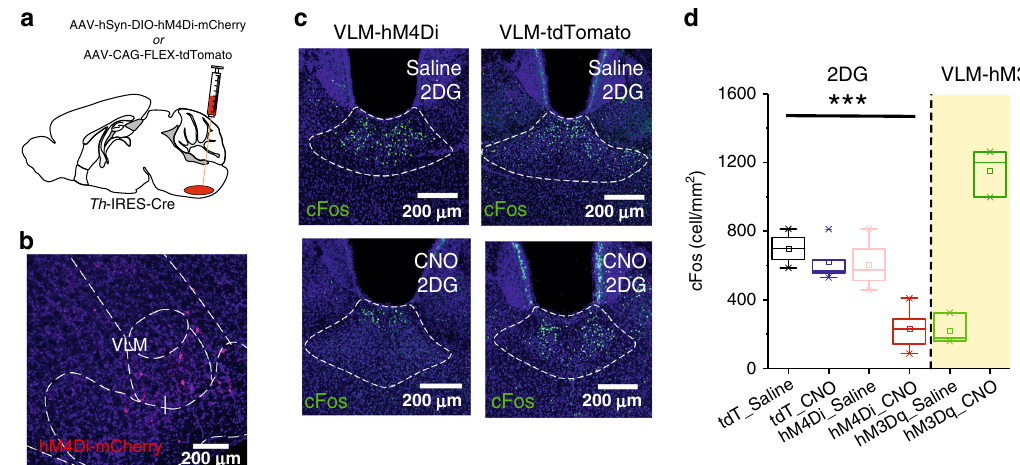
Fig. 6 VLM CA neurons mediate glucoprivation-induced activation of the pPVT. a Schematic of the stereotaxic injections for selective expression of DREADDi (hM4Di-mCherry) in VLM CA neurons of TH-IRES-Cre mice. b Representative images of the VLM from a TH-IRES-Cre mouse expressing the hM4Di-mCherry virus. c Representative images showing cFos immunohistochemistry in the pPVT of mice expressing either the hM4Di-mCherry (left) or tdTomato control virus (right) in the VLM CA and injected with either saline (top) or with CNO (bottom), 30 min before administration of 2DG. d Quanti fi cation of cFos immunoreactivity in PVT as cells/mm 2 , tdT-Saline, 698.85 ± 46.88, n = 6 mice; tdT-CNO, 619.06 ± 51.00, n = 6 mice; hM4Di- Saline, 603.80 ± 53.13, n = 6 mice; hM4Di-CNO, 229.65± 46.19, n = 6 mice; effect of treatments, F (1,17) = 19.70, P < 0.001; effect of virus, F (1,17) = 22.43, P < 0.001; interaction, F (1,17) = 8.28, P < 0.05, two-way analysis of variance (ANOVA) followed by Tukey ’ s test. Group comparisons: tdT_Saline vs hM4Di_CNO, *** P = 0.00004, tdT_CNO vs hM4Di_CNO, *** P = 0.0002, hM4Di_Saline vs hM4Di_CNO, *** P = 0.0002. Data from Supplementary Fig. 4 included for comparison purposes (shaded portion of the graph). Box chart legend: box is de fi ned by 25th, 75th percentiles, whiskers are determined by 5th and 95th percentiles, and mean is depicted by the square symbol. Data presented as mean ±